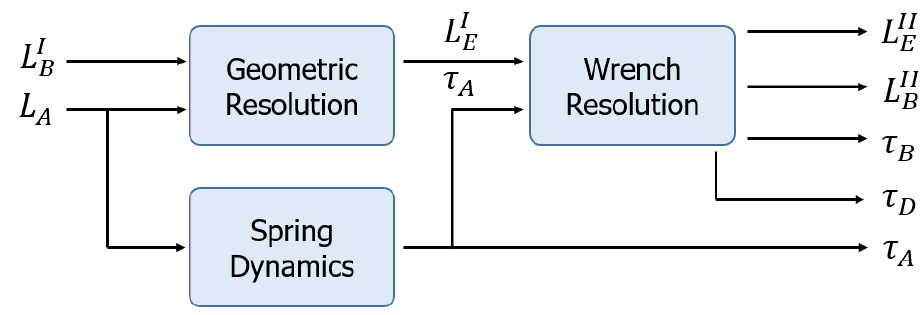
Figure 5. Scheme of the resolution of the kinetostatic of the compliant actuator of the robot.